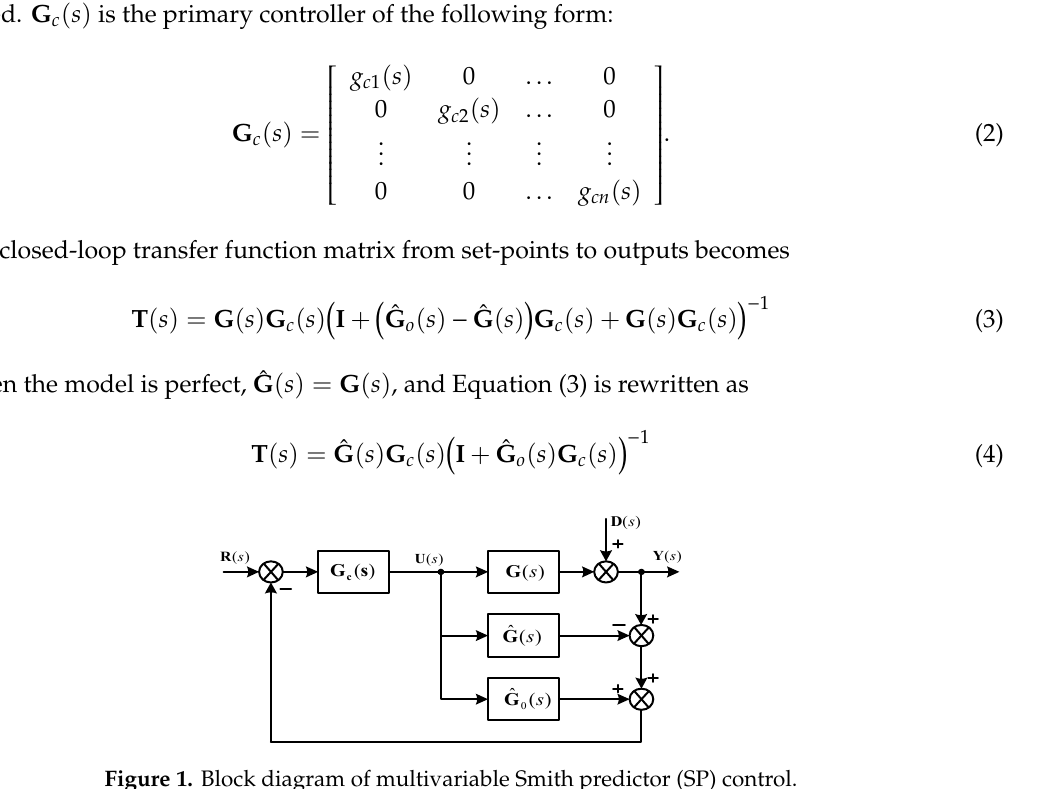
Figure 1. Block diagram of multivariable Smith predictor (SP) control.